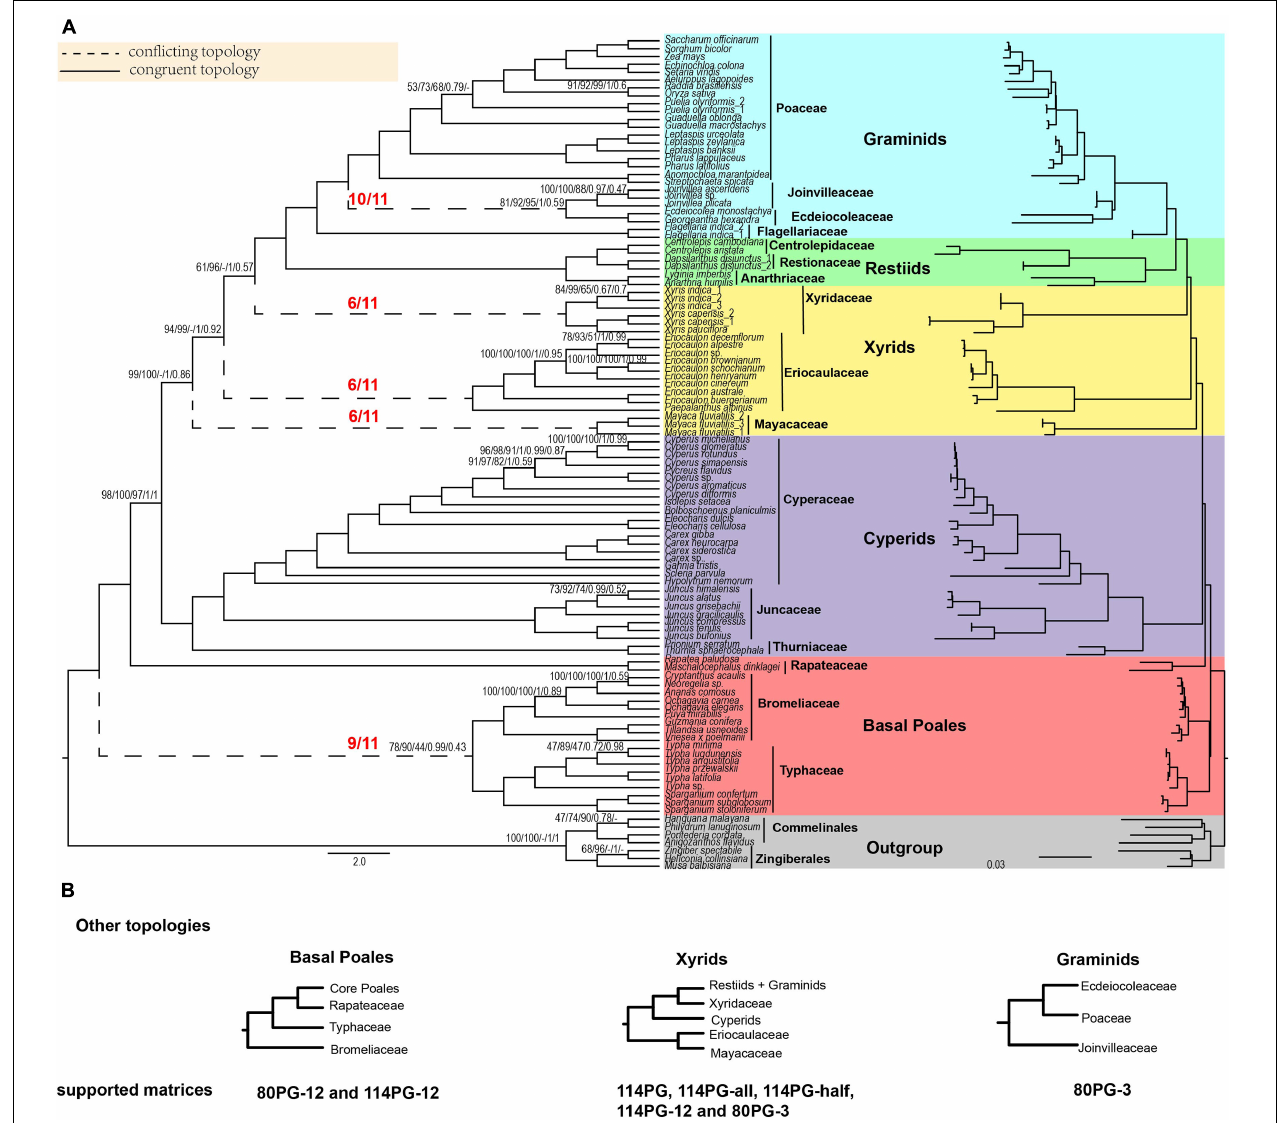
FIGURE 1 | Poales phylogeny based on plastid genes and main conflicting topologies. (A) The Poales phylogeny is based on 80 plastid genes using Gblocks with no gap positions allowed (80PG-no). The red fractions on the branches represented by dotted lines indicate the supported numbers in the 11 matrices. Support values are given above branches with the order RAxML bootstrap (MLBS) values/IQ-TREE bootstrap (UFBS) values/MP bootstrap (MPBS)/posterior probability (PP) values/local posterior probability (LPP) values. Support values are only displayed for branches with BS support less than 100%, posterior probability less than 1.00, or local posterior probability less than 1.00. The conflicting topologies are indicated by “–”. Different colors represent different clades: Early diverging Poales in red, cyperids in purple, xyrids in yellow, restiids in green, graminids in blue, and the outgroup in gray. (B) Other topologies are different from panel (A) of basal Poales, xyrids, and graminids recovered in corresponding matrices. Note: -all, -half, and -no mean that using Gblocks with allowing gap positions with all, with half, and none. -12 mean 1st + 2nd condon position of the matrix; -3 mean 3rd codon position of the